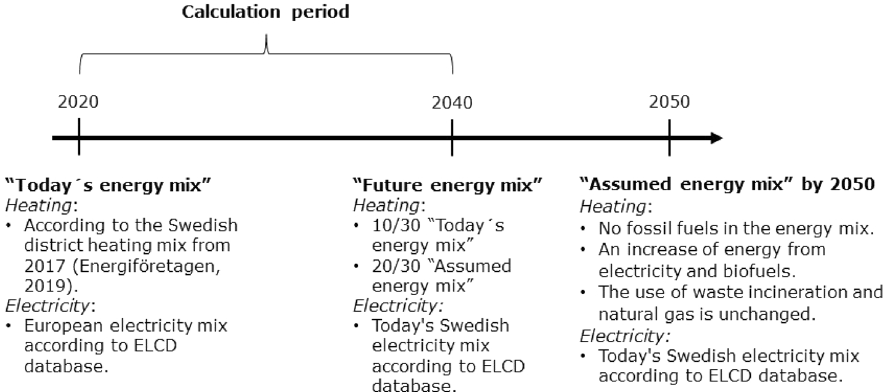
Fig. 1 How the energy sce- nario “Future energy mix” is assumed to improve the mix of energy sources in the district heating